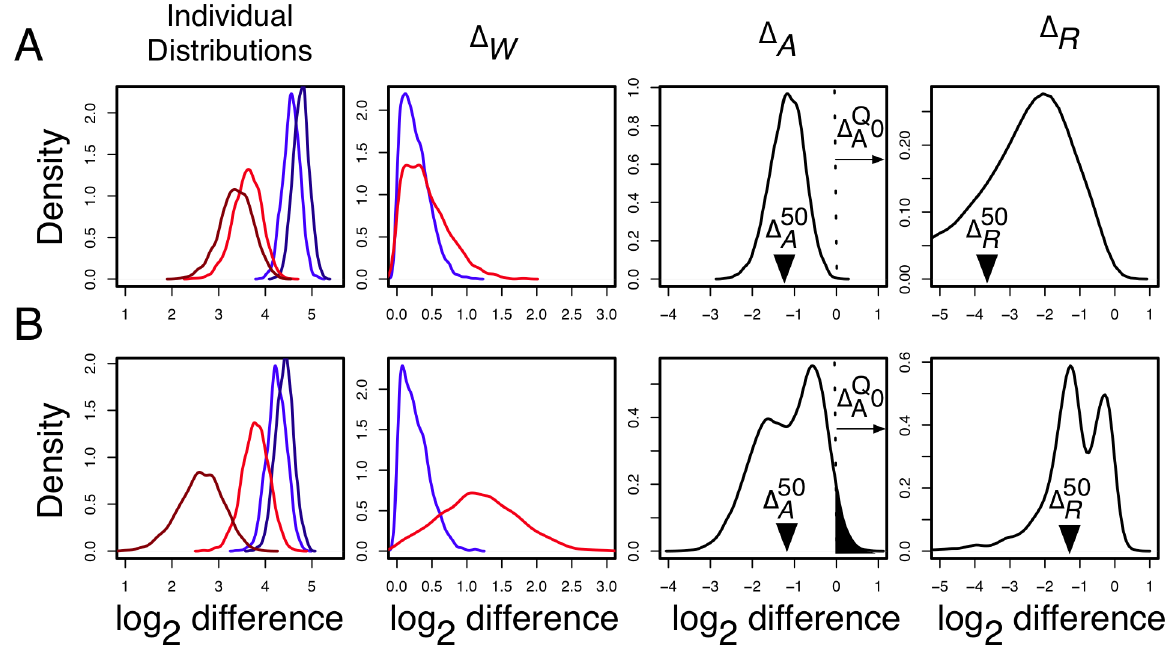
Figure 3. Approximate ANOVA via Absolute and Relative fold differences. The figure shows how the method explicitly accounts for the within-condition dispersion using as an example two genes with similar absolute fold differences ( D A ) of -1.17 and -1.13 but very different relative values in the L-K dataset. Dirichlet sampled distributions are generated from the raw read counts as described in the fold differences ( D R ) and D Q 0 A text. These distributions are log-transformed and the noninformative subspace is removed. Posterior distributions of q ijk are shown for j ~ f liver = blue,kidney = red g and for replicates k ~ f lane1 = light,lane2 = dark g . Both genes are abundantly expressed in this dataset, with median expression levels between 2 3 and 2 5 greater than the mean across-gene expression level. D A is computed by randomly sampling one of the red distributions, randomly sampling one of the blue distributions, and subtracting for all pairs of between-condition distributions. D W is computed by sampling a light and a dark from each red and blue distributions, subtracting light and dark, and selecting the difference with the greatest magnitude. D R is computed as the ratio of a single realization of D A and D W , and is computed for each realization of D A and D W . The D A distribution , the quantile of zero in D A , is narrower in A than in B implying a greater precision in estimating this value. This precision can be estimated by D Q 0 A values are 0.0001 and 0.035 in panels A and B which is shown graphically as the black-filled area under the D A distribution curves. The D Q 0 A respectively. The vertical arrows show the median values of D A and D R . Thus, the between-condition expression values for the gene in Panel A are v 0 : 01 ) but not for the gene in Panel B ( j D ƒ 1 : 5, D Q 0 w 0 : 01 ). These conclusions agree with inspection- scored as separable by ALDEx ( j D R j § 1 : 5, D Q 0 R j A A based intuition from examining the initial adjusted log-expression distributions that are shown in the left